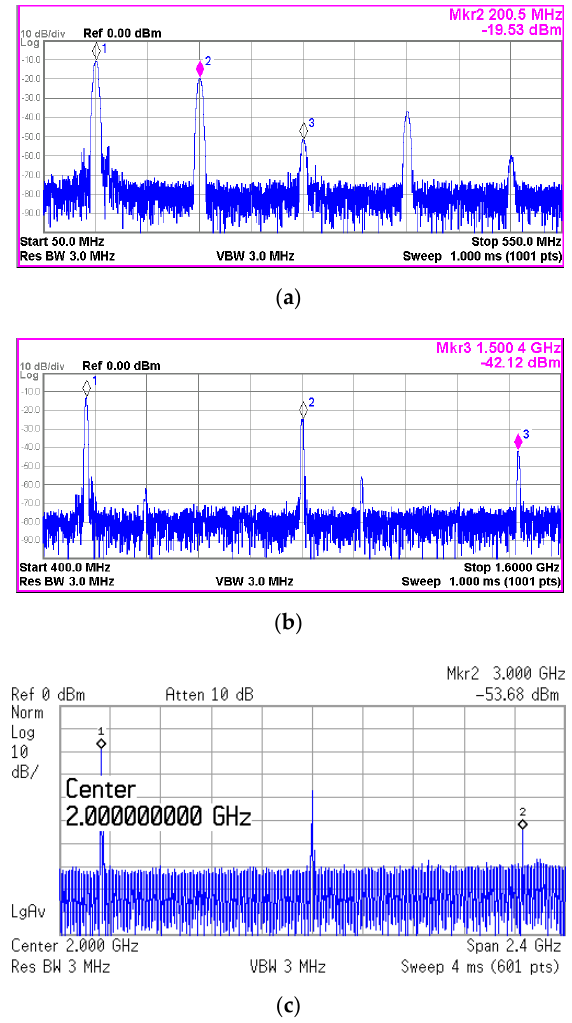
Figure 13. ( a ) Measured output spectrum for the input of 0.5 V peak-to-peak @ 100 MHz. ( b ) Measured output spectrum for the input of 0.5 V peak-to-peak @ 500 MHz. ( c ) Measured output spectrum for the input of 0.5 V peak-to-peak @ 1 GHz.